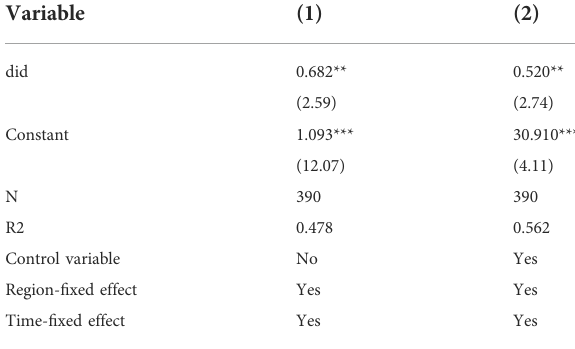
TABLE 6 Regression results of surrogate index